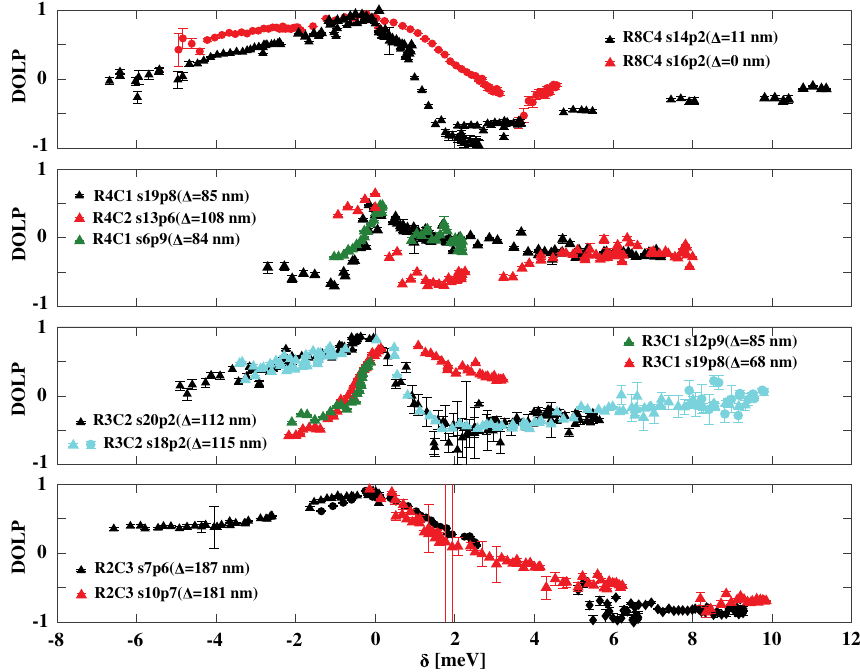
FIG. 12. DOLP traces for different Δ values. CM-QD detuning was modified using a combination of temperature variations and a CM energy tuning using water vapor deposition during the sample cooldown process.